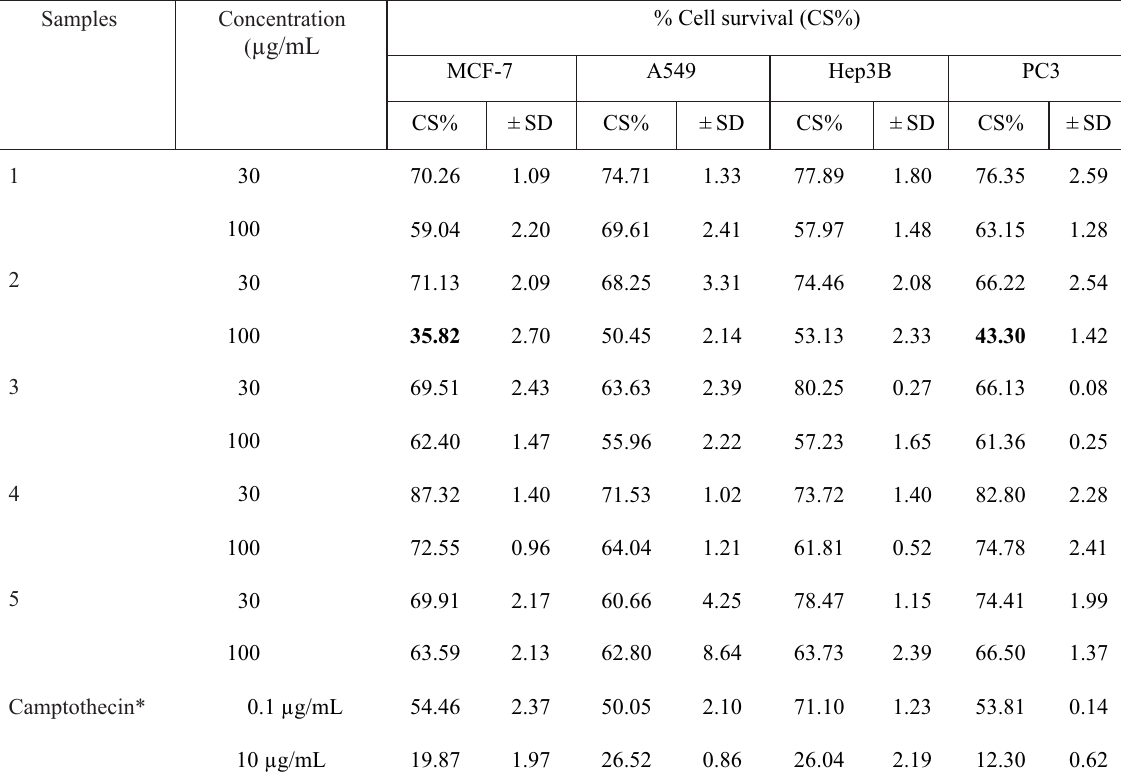
Table 3. Cytotoxicity of the isolated